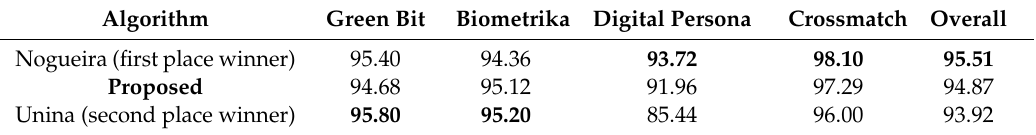
Table 4. Comparison between the results of the proposed fingerprint branch net and the best methods from the LivDet 2015 competition, where we present the average accuracy